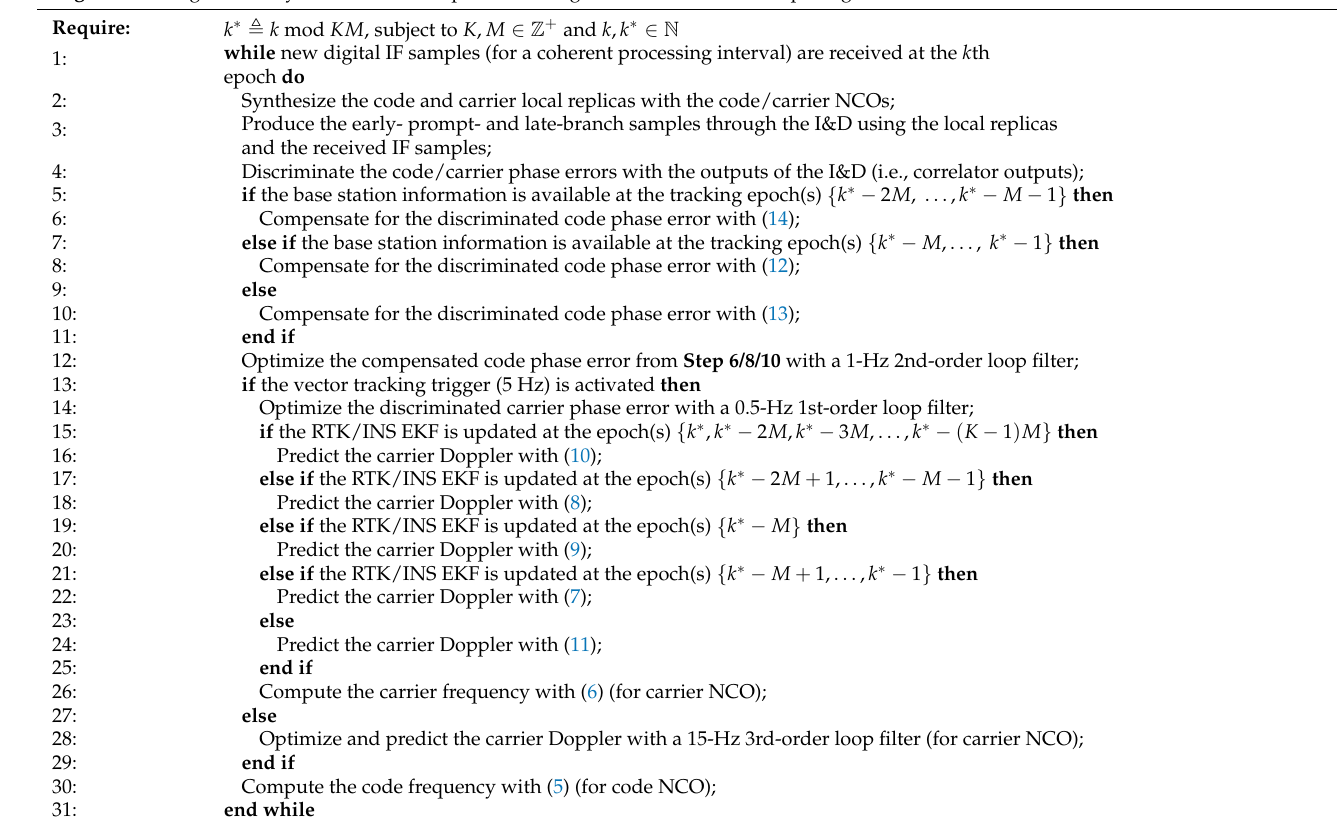
Algorithm 1 High-accuracy APA GNSS code phase tracking based on RTK/INS deep